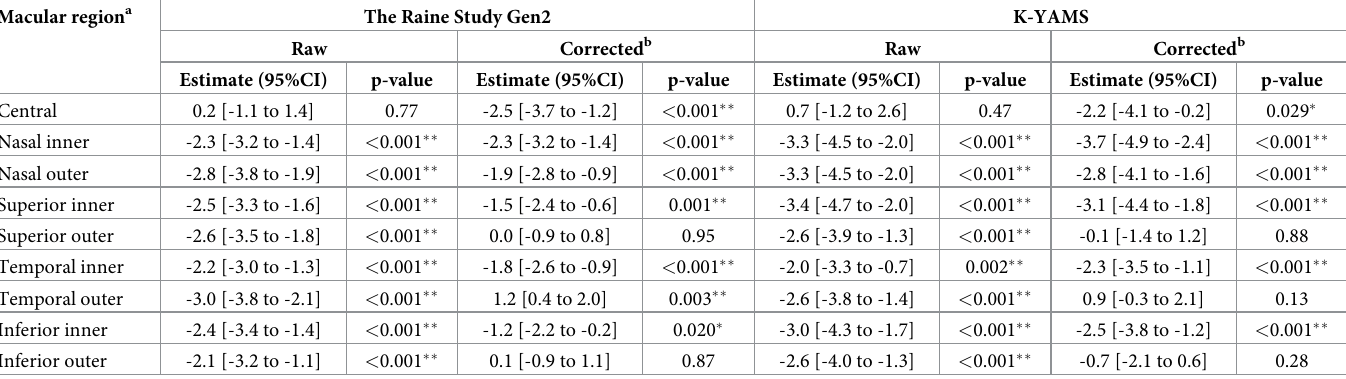
Table 2. Estimated difference in retinal thickness ( μ m) per 1mm increase in axial